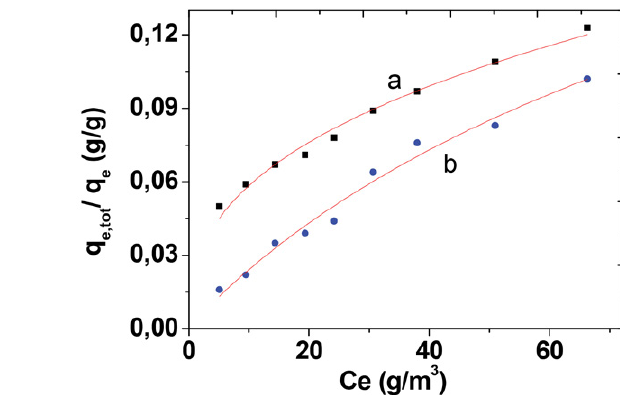
Figure 7. Adsorption Isotherms a-co-adsorption of benzene -H 2 O; b- benzene on Adsorbent 4 (rH = 50%, t = 26 °C)